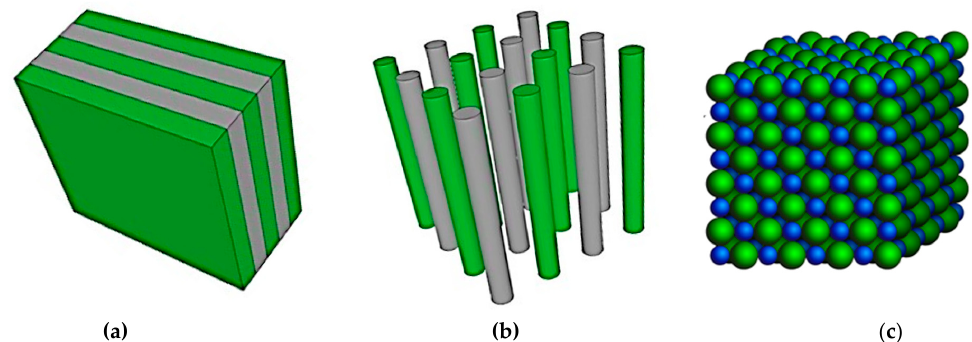
Figure 1. Diagrams of periodic structures in different dimensions: ( a ) one dimension; ( b ) two dimensions; ( c ) three